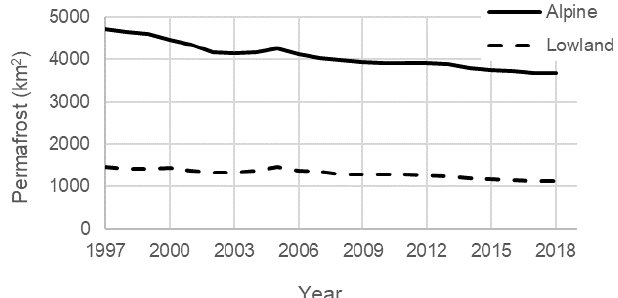
Figure 13. Modelled permafrost extent of alpine ( > 700ma.s.l.) and lowland permafrost for the years 1997–2018 in the Baltic Sea drainage basin. Data source: Permafrost data are from Obu et al. (2020), the extent of the catchment is from Hannerz and Destouni (2006), and the elevation data are from the U.S. Geo- logical Survey (USGS) Global Multi-resolution Terrain Elevation Data 2010 (GMTED2010). Analyses are performed at 1km resolu- tion in an equal area